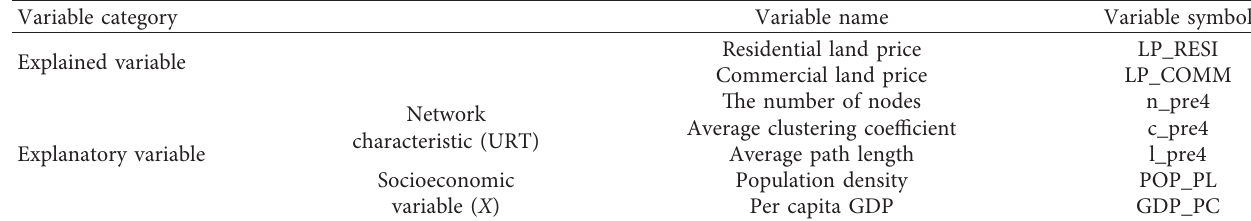
Table 2: Description of model variables.